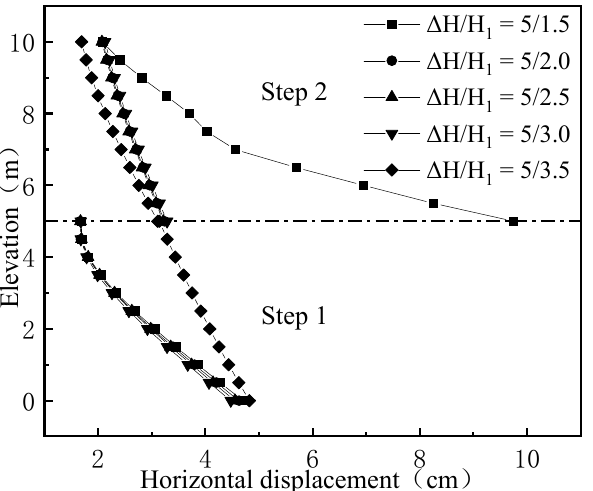
∆ H / H H H Δ on the maximum horizontal displacement of panel. Figure 16. The influence of 1 on the maximum horizontal displacement of panel. Figure 16. The influence of 1 It can be seen from Figure 16 that the horizontal displacement of retaining wall panel decreases with the increase of height. The influence of parameter ∆ H / H 1 on the horizontal displacement of the panel is reflected in the following two aspects: (1) For step 1, except for ∆ H / H 1 = 5/3.5, the panel displacement curves under the other four working conditions are close to coincide. The overall horizontal displacement of step 1 is the largest when ∆ H / H 1 = 5/3.5, and the average horizontal displacement is about 1.1 cm higher than that under other working conditions. It shows that under certain conditions, the reinforcement effect in the middle and upper area of the retaining wall is better than that in other positions, which is consistent with the previous conclusion. (2) When ∆ H / H 1 = 5/1.5, the overall displacement of step 2 reaches the maximum, and the average displacement of the panel reaches 6.2 cm, which is much larger than other working conditions. The minimum overall displacement of step 2 occurs when ∆ H / H 1 = 5/3.5, and the average displacement of the panel is about 2.4 cm, with a difference of about 61.3%. It can be seen that the laying position of reinforcement has a significant influence on the horizontal displacement of